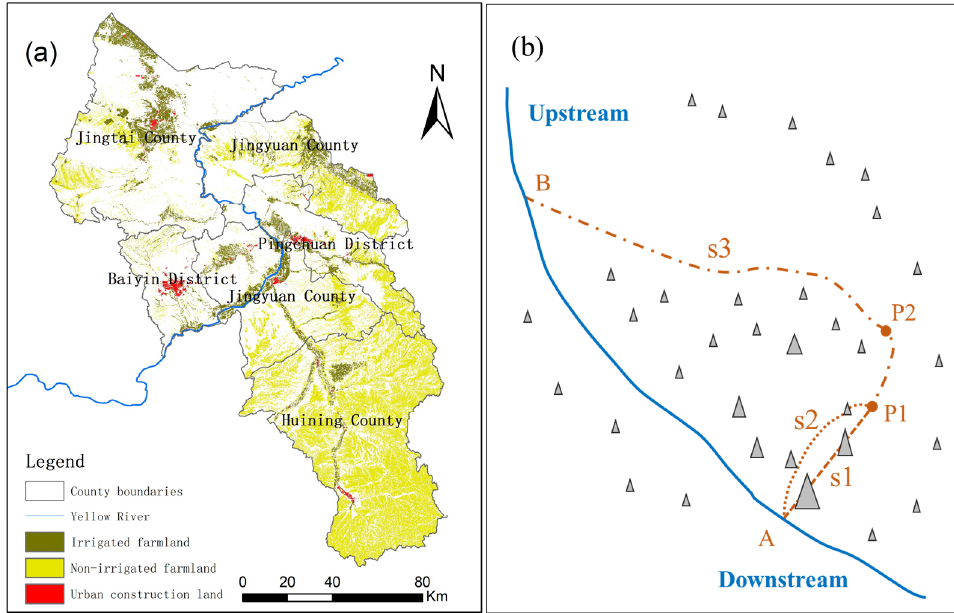
Figure 2. ( a ) Distribution of cultivated land and urban construction land; ( b ) difference between water source distance and water accessibility.